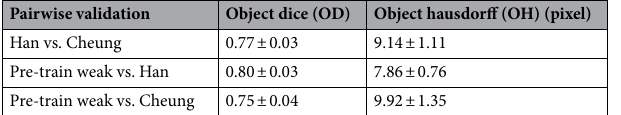
Table 3. Comparative results for O-test2 dataset for researcher (Han) and expert (Cheung) annotations.